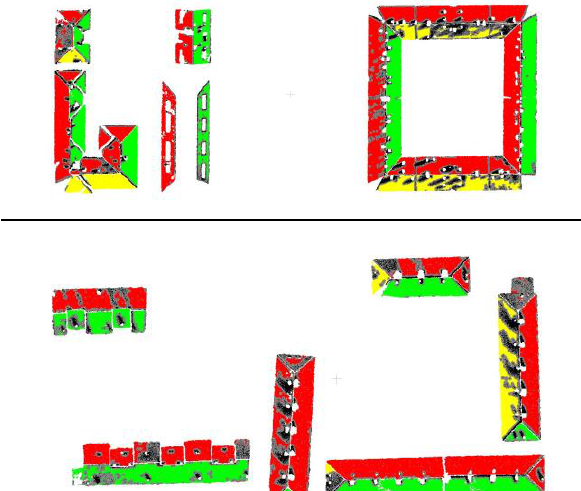
Figure 12. Details of the previous point cloud segmented and classified after the thermographic analysis. (Black) Points removed by the statistical thermographic analysis. (Grey) Perimeter defined by a user parameter (distance) around the Table 4. Example of the results after the geometric analysis for obstacles detected to help the optimum location to place the a roof of the solar panels.